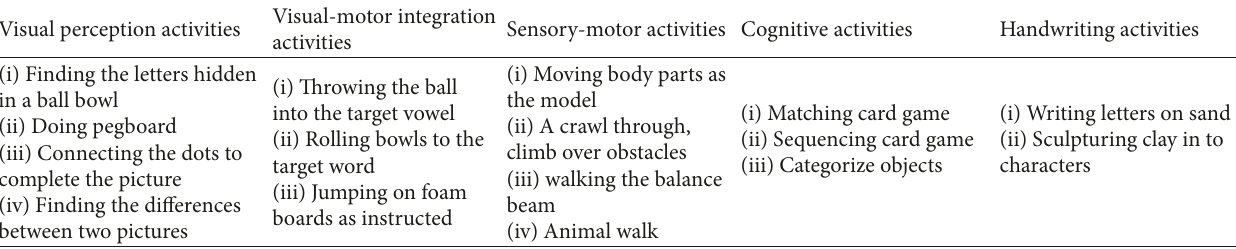
Table 3: Example of activities in the traditional program for the control group.